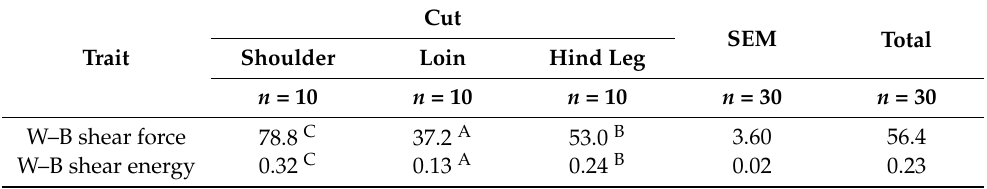
Table 3. Warner–Bratzler shear force (N) and energy (mJ) of cooked beaver meat. Cut SEM Total Shoulder Loin Hind Leg Trait n = 10 n = 10 n = 10 n = 30 n =